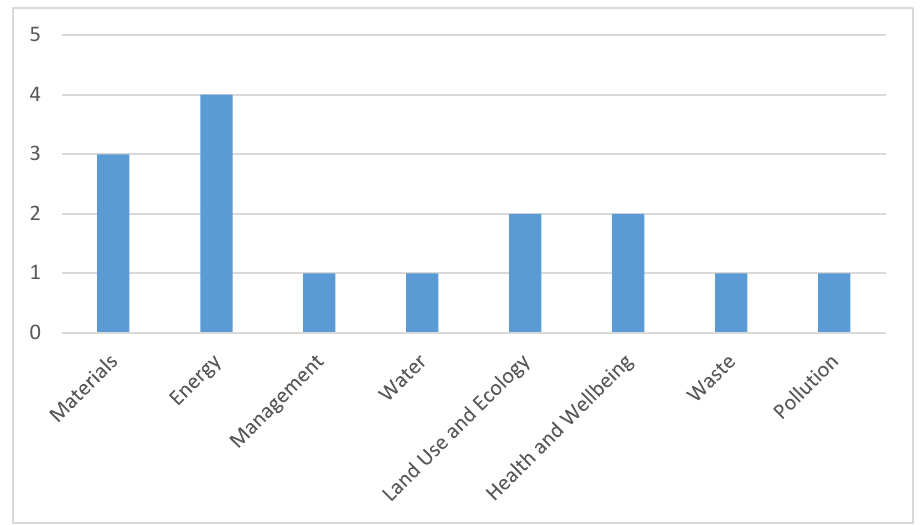
Figure 3. BREEAM categories assessed with Building Information Modelling (BIM).